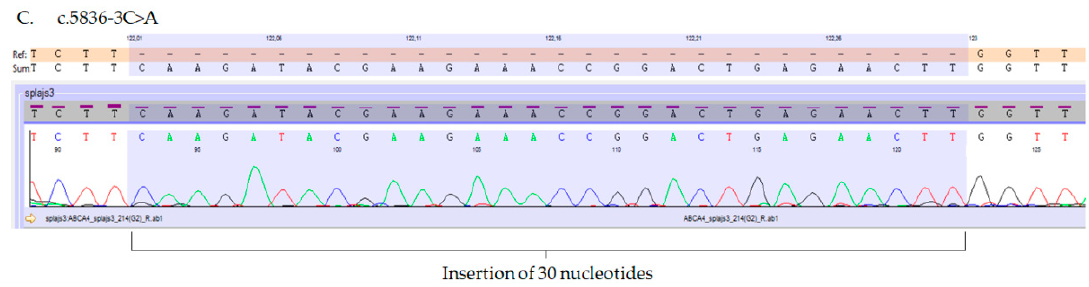
Figure 3. Electropherograms of the mutated ABCA4 transcripts isolated from hair follicles. ( A , B ) Mutations c.5312+1G>A and c.5312+2T>G result in the exon 37 skipping. Boundaries of exon 36 and 38 are marked in yellow. ( C ) Mutation c.5836-3C>A results in an insertion of 30 nucleotides (marked purple) into the ABCA4 transcript between the 41st and 42nd exon of the ABCA4 transcript.